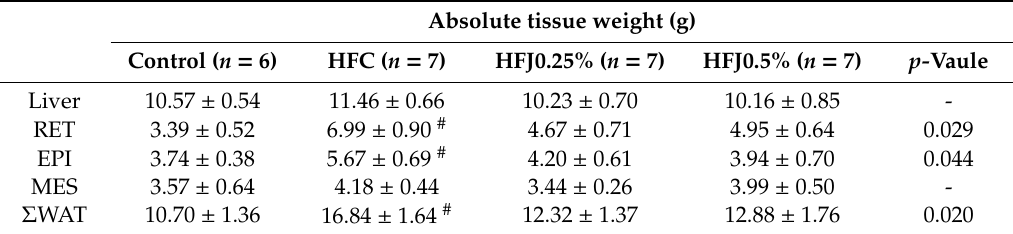
Table 1. Absolute tissue weight on di ff erent experimental